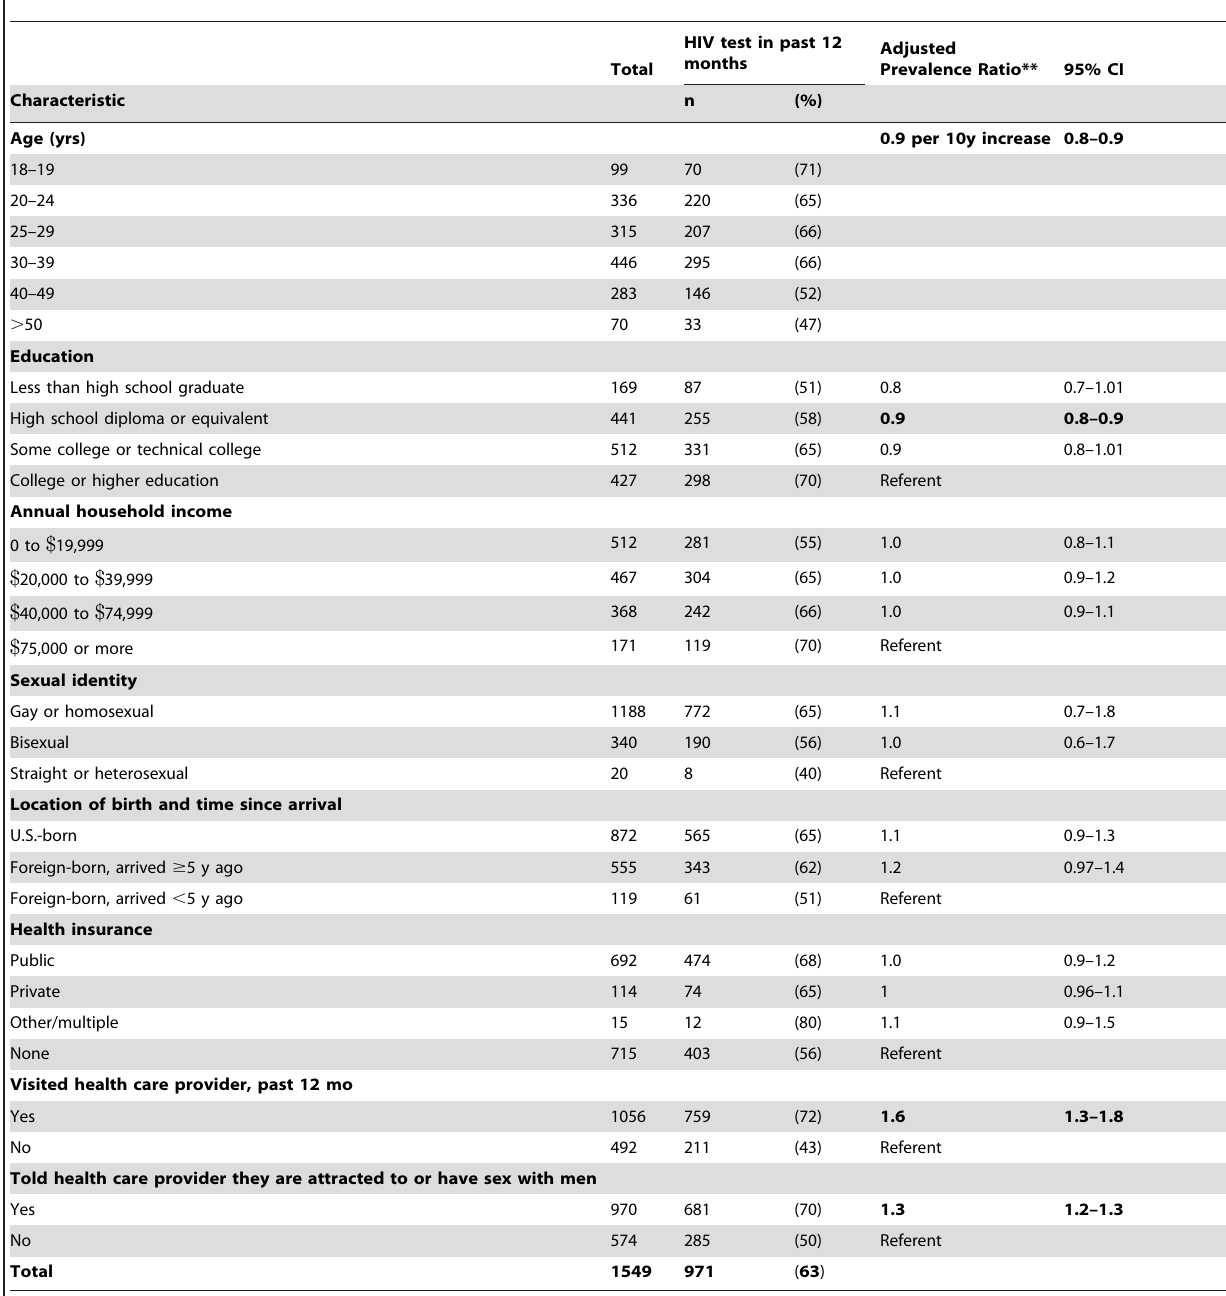
Table 4. Recent HIV testing among Latino MSM and adjusted prevalence of testing – 20 U.S. Cities, National HIV Behavioral Surveillance System, 2008 *